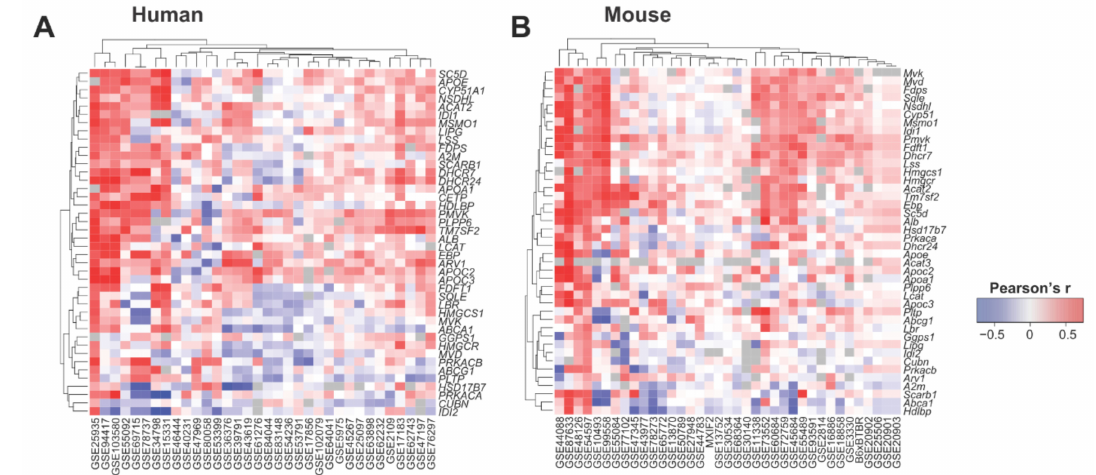
Figure 6. Tstd1 co-expressed with key genes involved in HDL and cholesterol synthesis in human and mouse. Heatmap showing the correlations between TSTD1/Tstd1 and key HDL and cholesterol genes in 34 and 37 liver transcriptome datasets from human ( A ) and mouse ( B ), respectively. Pearson’s correlation coefficients are indicated in the